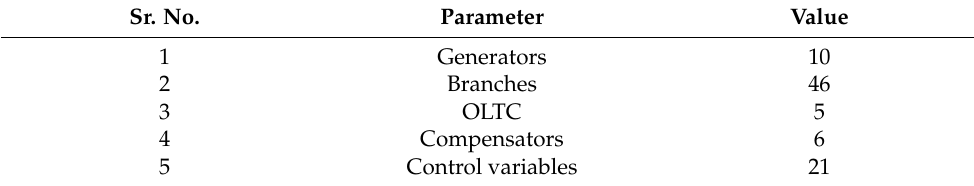
Table 6. Technical parameters of the IEEE 39 bus test